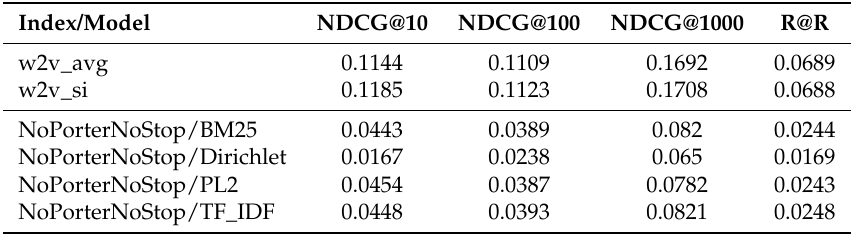
Table 9. T1: scores of NDCG and R@R of w2v runs and Terrier with NoPorterNoStop index.